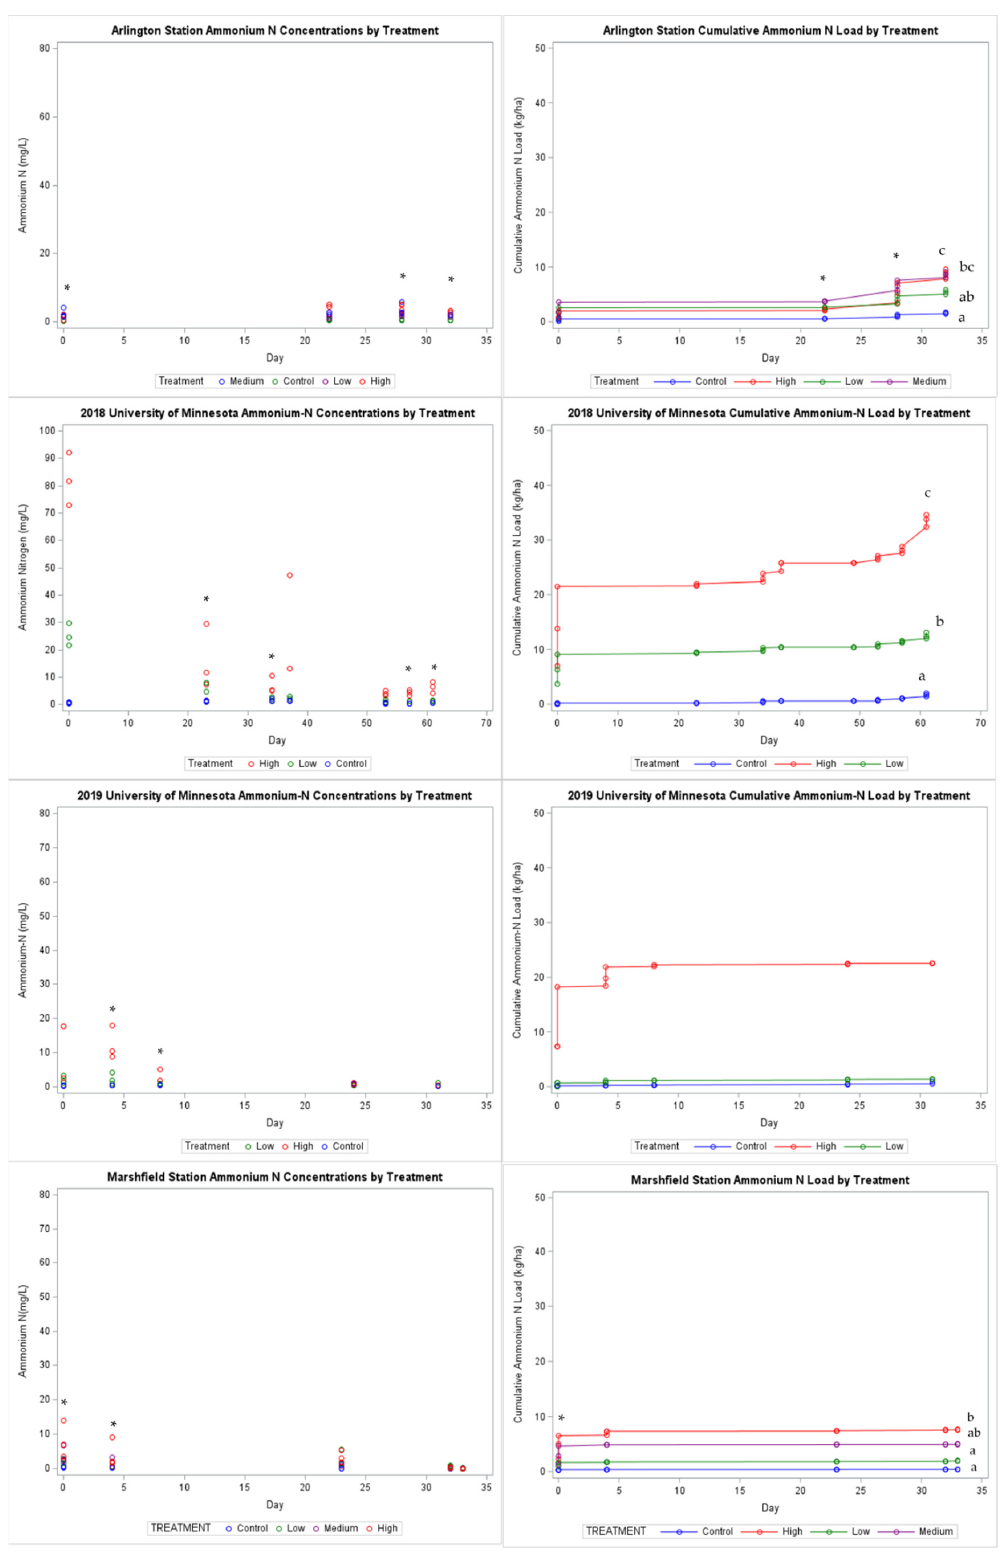
Figure 7 . Snowmelt runoff total nitrogen (TN) concentrations and loads by treatment for each site and year of the experiment. Asterisks indicate a significant ( p ≤ 0.05) main effect of manure solids content. Cumulative loads without a common lower case letter differ ( p ≤ 0.05).